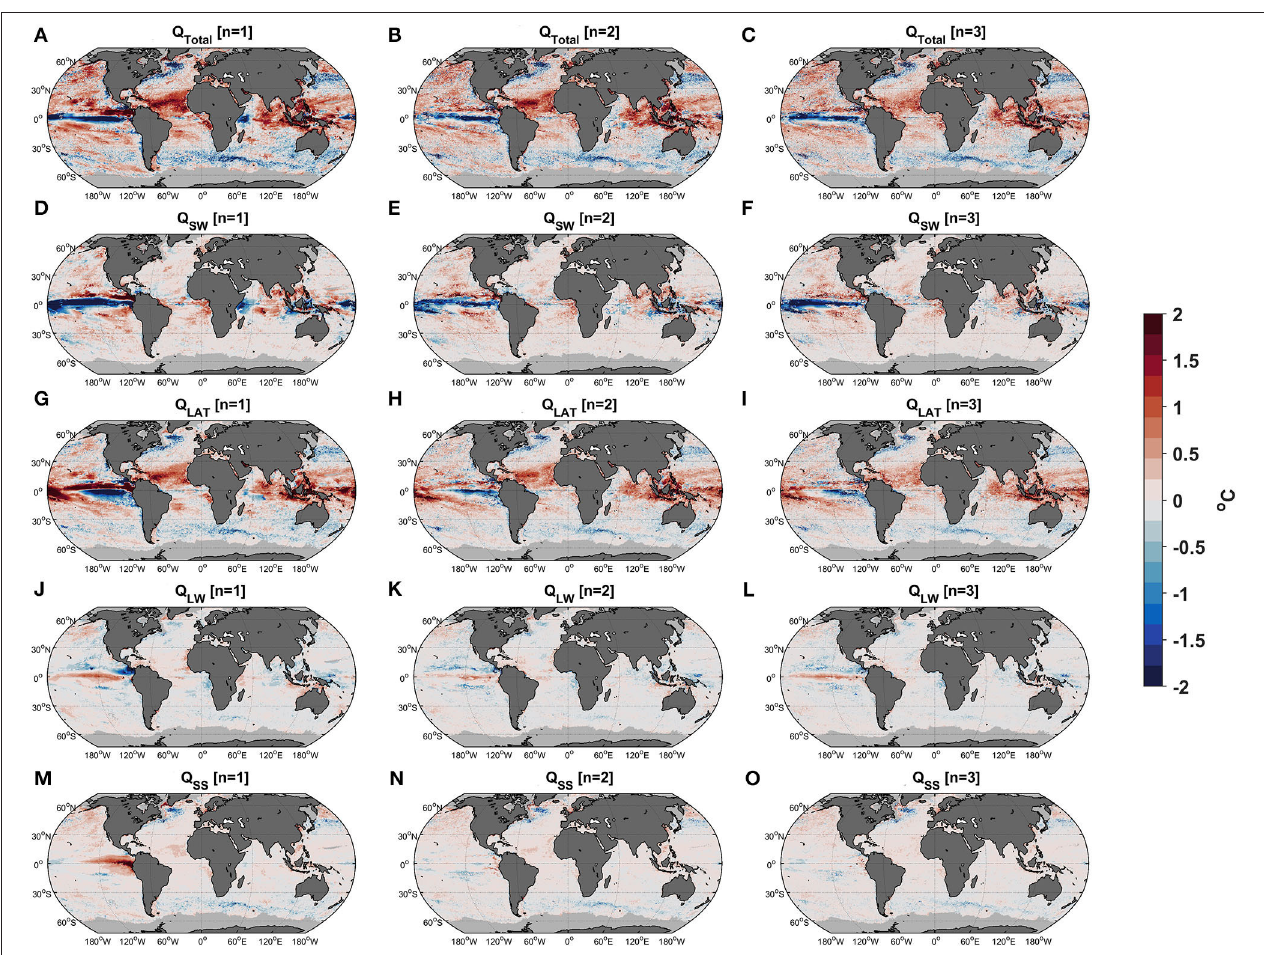
FIGURE 7 | Decomposition of net air-sea heat flux contribution to the onset of the three strongest MHW events. (A–C) Net air-sea heat flux contribution to depth-averaged temperature anomaly change. Net air-sea heat flux was decomposed into (D–F) its shortwave radiation (G–I) latent heat flux (J–L) longwave radiation and (M–O) sensible heat flux components. Grid points where onset periods started before Jan-1st 1984 or with sea-ice contamination were excluded from the analysis (gray shading). Positive heat flux is a flux into the ocean, and in the case of latent heat it also means a gain of freshwater at the ocean